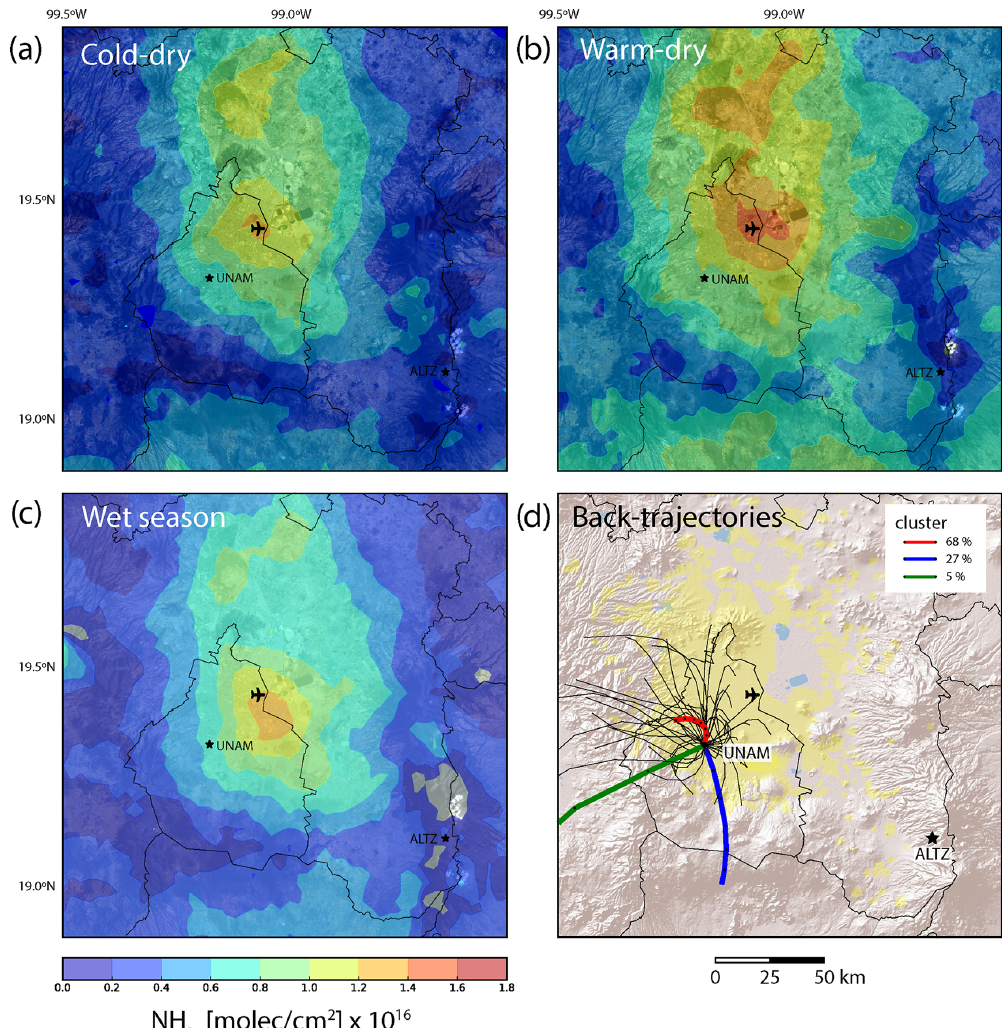
Figure 7. Spatial distribution of IASI-A NH 3 total columns for the morning overpass of MetOp-A over Mexico City, averaged over 2008– 2018 for (a) the cold–dry season (November–February), (b) the warm–dry season (March–May), and (c) the wet season (June–October). HYSPLIT back-trajectories for the UNAM site are shown in panel (d) . The black stars indicate the locations of both stations, and Mexico City International Airport is shown for